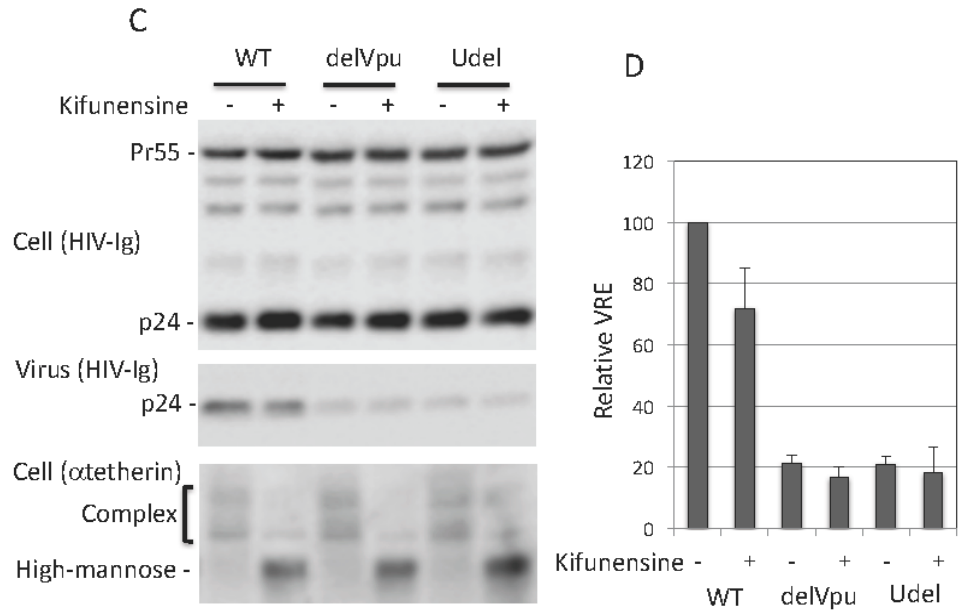
Figure 3. Complex-type glycosylation is dispensable for tetherin restriction. ( A ) 293T cells were transfected with WT, delVpu or Udel pNL4-3 HIV-1 molecular clones, and vectors expressing HA-tagged WT tetherin. Eight hours post transfection, cells were untreated or treated with 10 μ M kifunensine for 24 h, and cell and viral lysates were collected and subjected to western blot analysis with HIV-Ig, anti-HA or anti-Vpu antisera as in Figure 1A; ( B ) Virus release efficiency was calculated as in Figure 1B; VRE for WT HIV-1 in the absence of tetherin and kifunensine treatment was set to 100%; ( C ) HeLa cells were transfected with WT, delVpu or Udel pNL4-3 HIV-1 molecular clones, 8 h post transfection cells were untreated or treated with 10 μ M kifunensine. One day post treatment cell and viral lysates were collected and subjected to western blot analysis with HIV-Ig, or anti-tetherin antisera as in Figure 1A; ( D ) VRE was calculated as in Figure 1B; VRE for WT HIV-1 in the absence of kifunensine treatment was set to 100%; ( B , D ) Data shown are ± SD from three independent experiments.